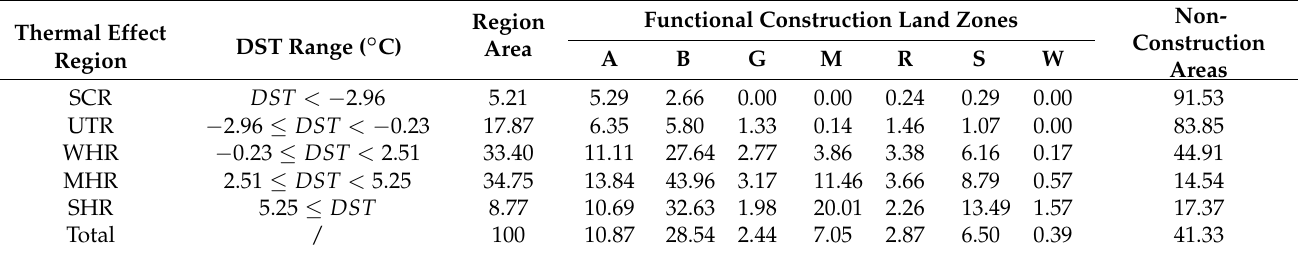
Table 3. Area Proportion (%) of functional construction land zones (FCLZs) in each thermal effect level